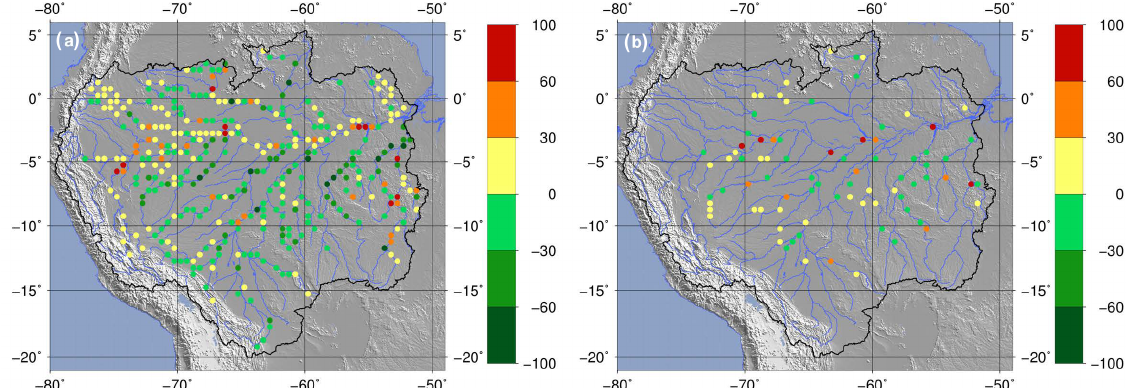
Figure 10. Analysis RMSEn difference between SE1-direct and the SE1-local experiment with respect to (a) the ENVISAT discharge and (b) gauge discharge. Negative RMSEn differences (green colours) mean that the results of the SE1-local experiment are better than the SE1- direct results at the given CTRIP cell. Positive RMSEn differences (yellow, orange and red colours) mean that the results of the SE1-direct experiment are better that the SE1-local results at the given CTRIP.